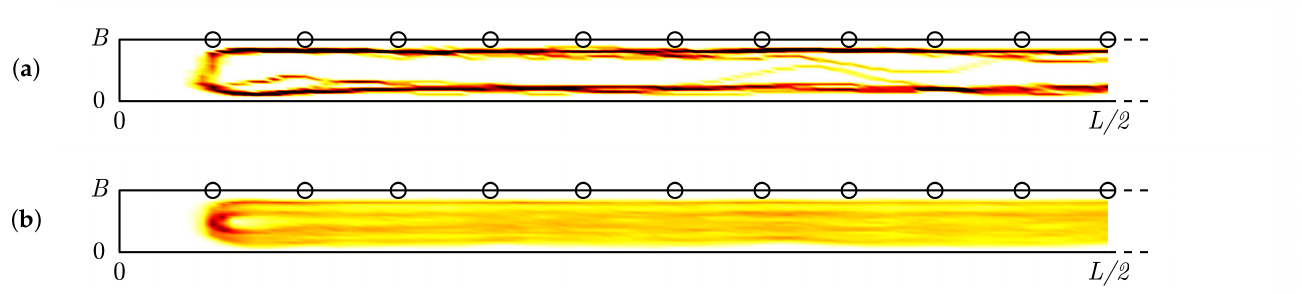
Figure 15. Heat map of the position for the case of walking for half a bridge deck (with length L and width B ) during test 1 of pedestrian density 0.50 pers./m 2 : ( a ) a single pedestrian and ( b ) the entire crowd (after